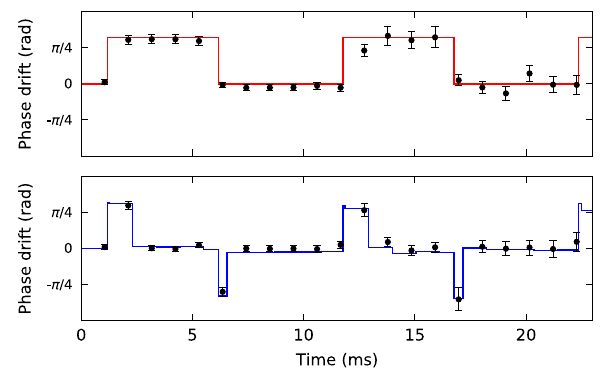
FIG. 5. Correction of phase jumps between the LO and the atomic ensemble. Evolution of the LO-CSS phase when periodic phase jumps of π = 3 are applied back and forth on the LO: The points are obtained from the measured population difference, whereas the solid line represents the LO phase measured after the correction phase actuator. The controller, implemented using coherence-preserving measurements and feedback on a phase actuator, maintains the relative phase close to 0. Above, the system is operated in an open loop, below in a closed loop. In the latter case, the phase corrections are applied 150 μ s after each measurement.